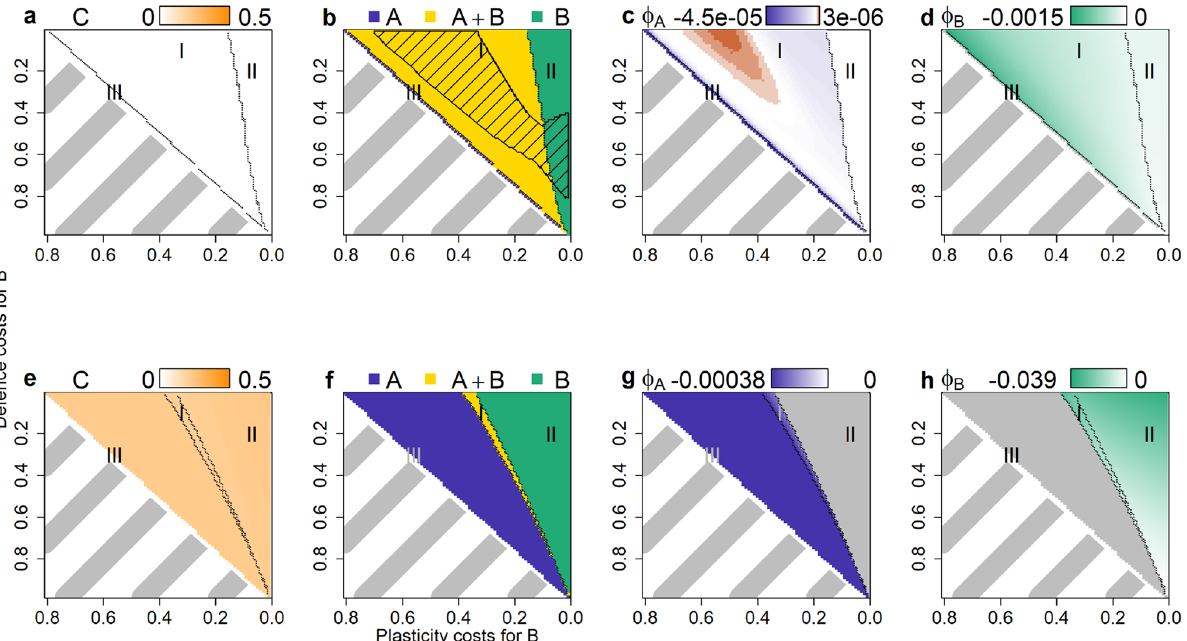
Figure 4. Coexistence and maladaptive switching for scenario crossing 0.01 ( a - d ) and crossing 1 ( e – h ). Consumer biomass ( a , e ), the autotroph coexistence patterns ( b , f ), and the autotrophs’ maladaptive switching Φ ( c , d , g , h ) (higher biomasses or more intensive maladaptive switching are shown by darker colours). Lines separate the regions I–III of different autotroph coexistence. The x- and y-axis are reversed to follow the pattern of increasing fitness. Shaded areas in ( b ) depict antiphase cycles. Grey areas in ( c , d , g , h ) depict areas where the species was extinct. Shaded grey areas depict areas without simulations (cf. “Methods”). Note that ( c , d , g , h ) have each a different colour scale.